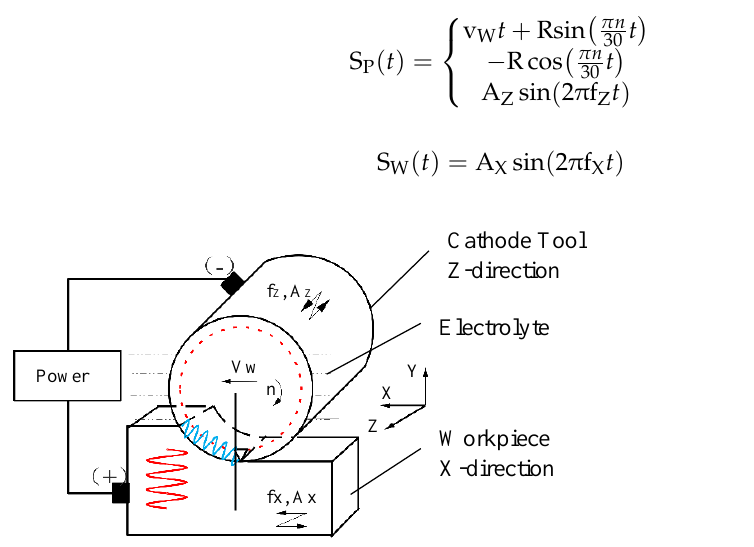
Figure 1. The machining mechanism of